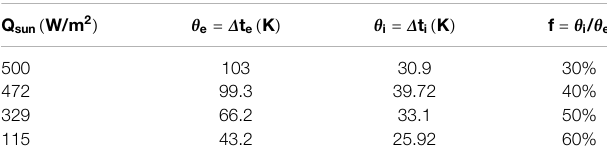
TABLE 2 | Attenuation ratio when different heat fl ux